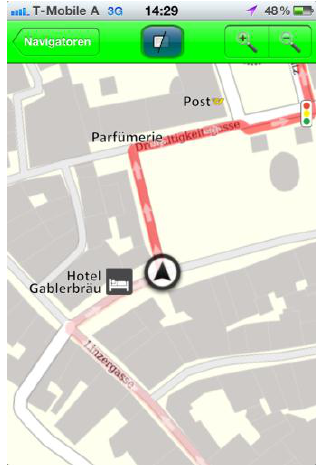
Figure 1. A screenshot of the map-based interface, with an egocentric view, distinction between the past and future paths, automatic adaptation to real-time location, zooming and panning functions, etc (© Salzburg Research, Map data: OpenStreetMap and Contributors, CC-BY-SA).